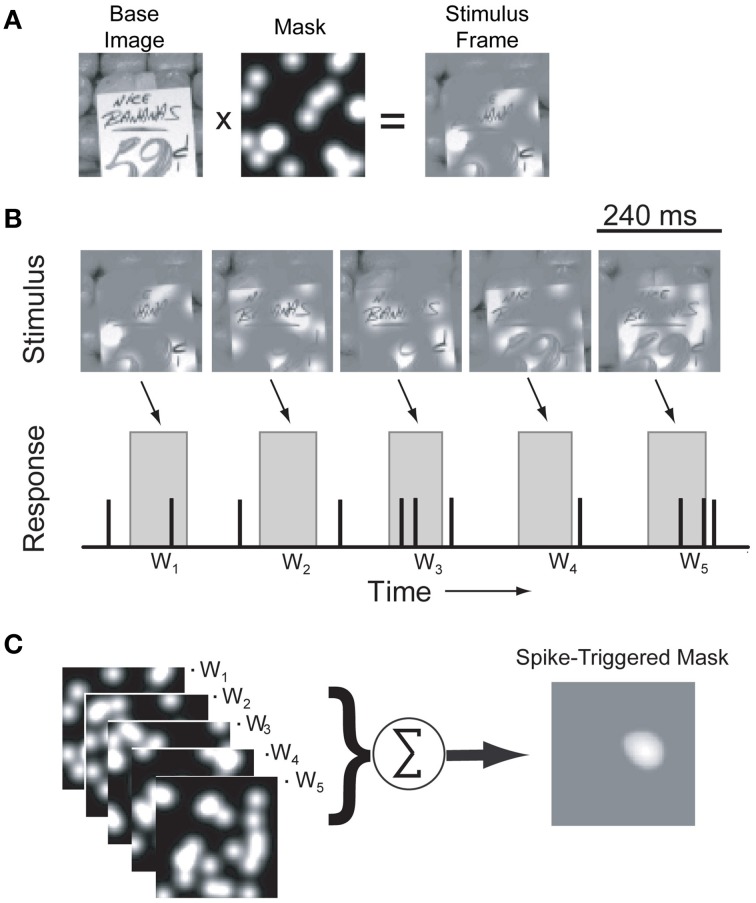
Identification of driving features using bubble-masked natural images. (A) Each frame of the stimulus sequence was created by combining a pre-selected natural scene photograph (see Materials and Methods) with an opaque mask perforated by randomly distributed Gaussian windows. (B) Example stimulus frames for a single image and a simulated response. In each frame, the positions of the Gaussian windows are randomized. During the actual experiment, underlying base images were randomly interleaved to minimize adaptation effects (see text for details). Stimuli were presented at 4.25 Hz (240 ms/frame) and responses to each stimuli (wn) were determined by computing the mean firing rate in a window 50–150 ms after stimulus onset (gray boxes). (C) For each underlying image, masks were weighted by the recorded neuronal response and averaged to estimate an image-specific spike-triggered mask.